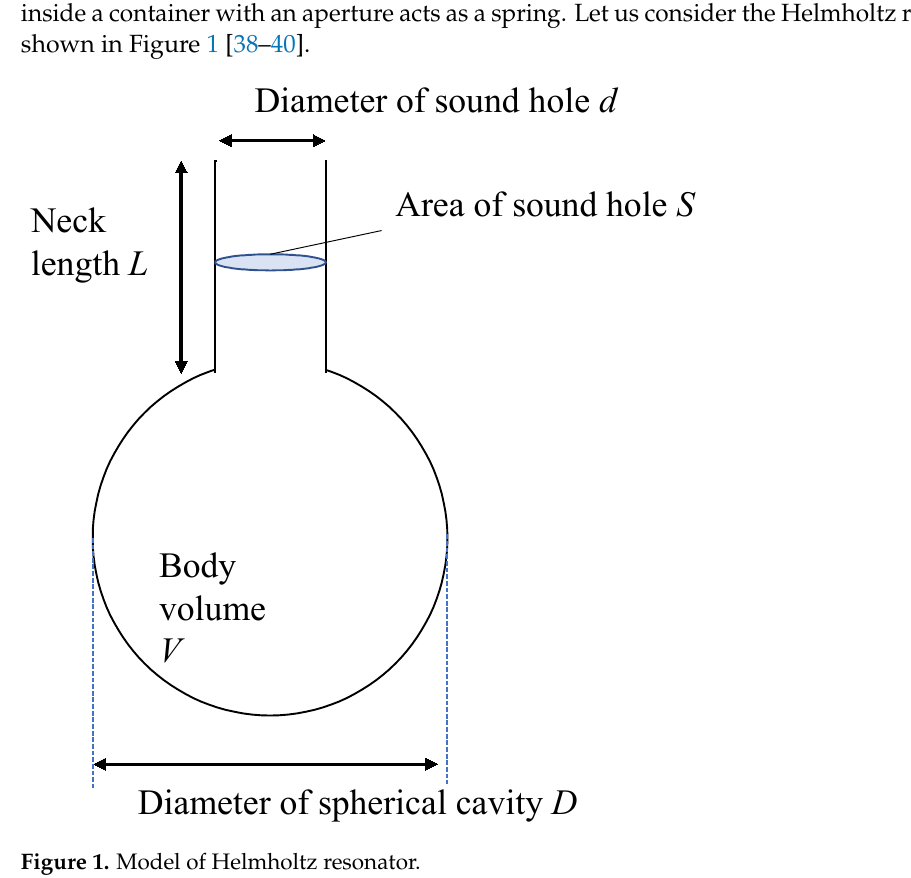
Figure 1. Model of Helmholtz resonator.